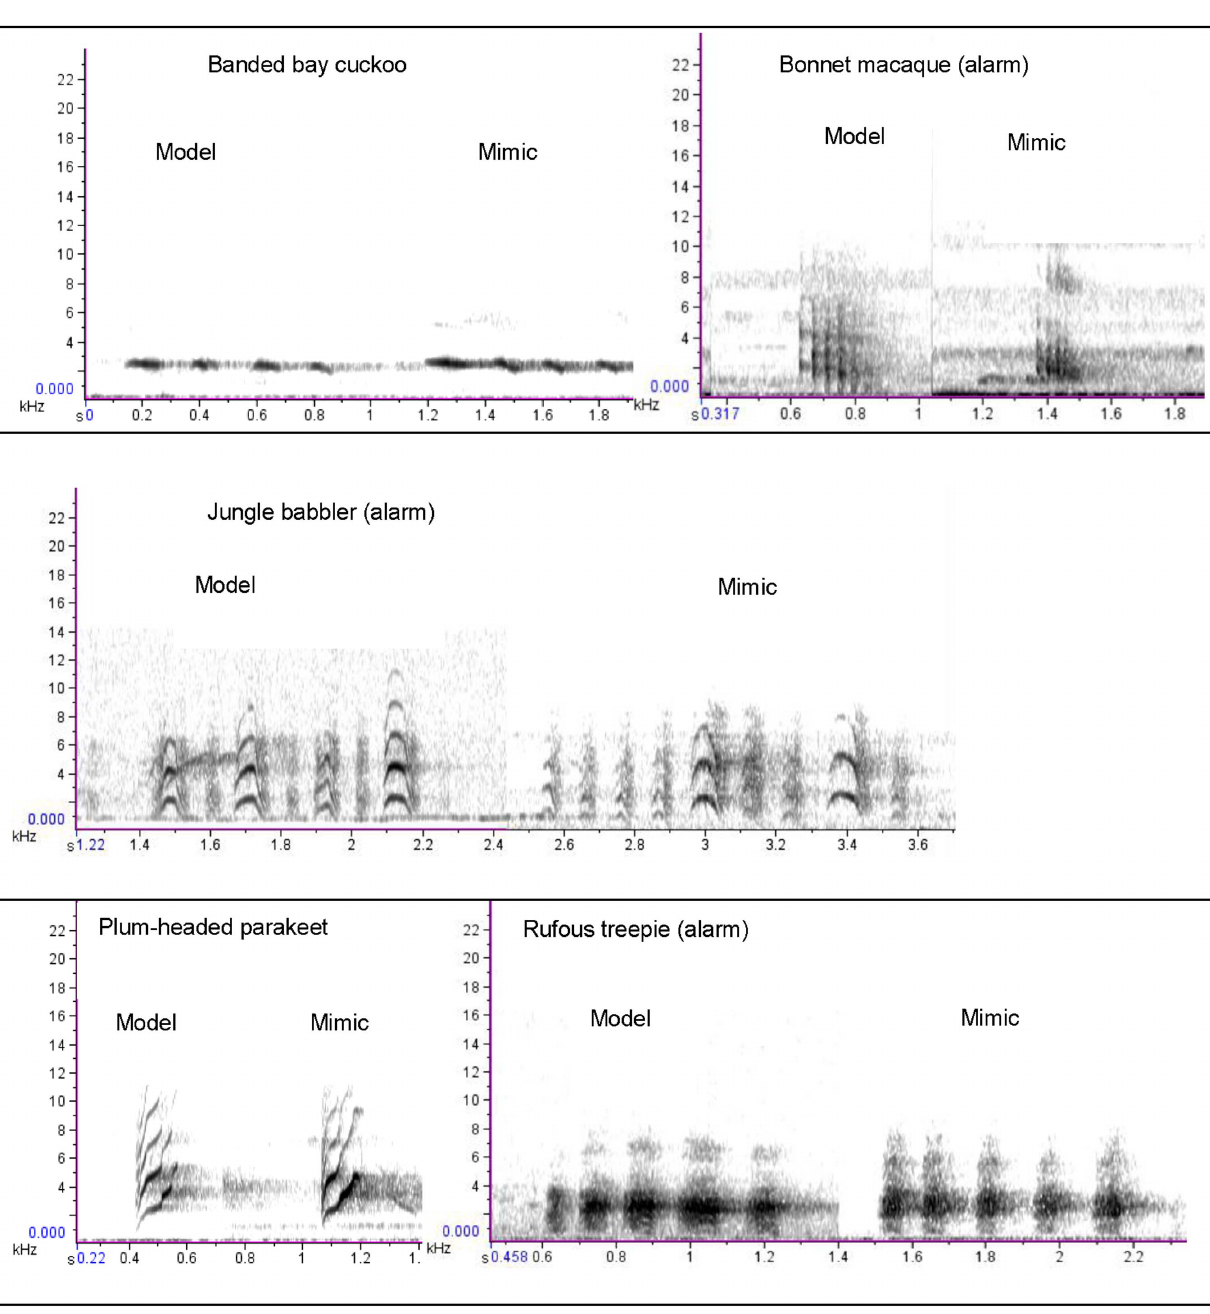
Figure 1. Model and mimic call spectrograms for five species (four birds and one mammal).